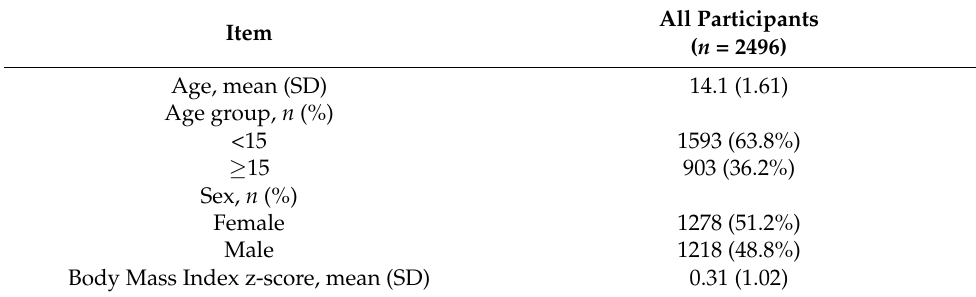
Table 1. Descriptive table of the